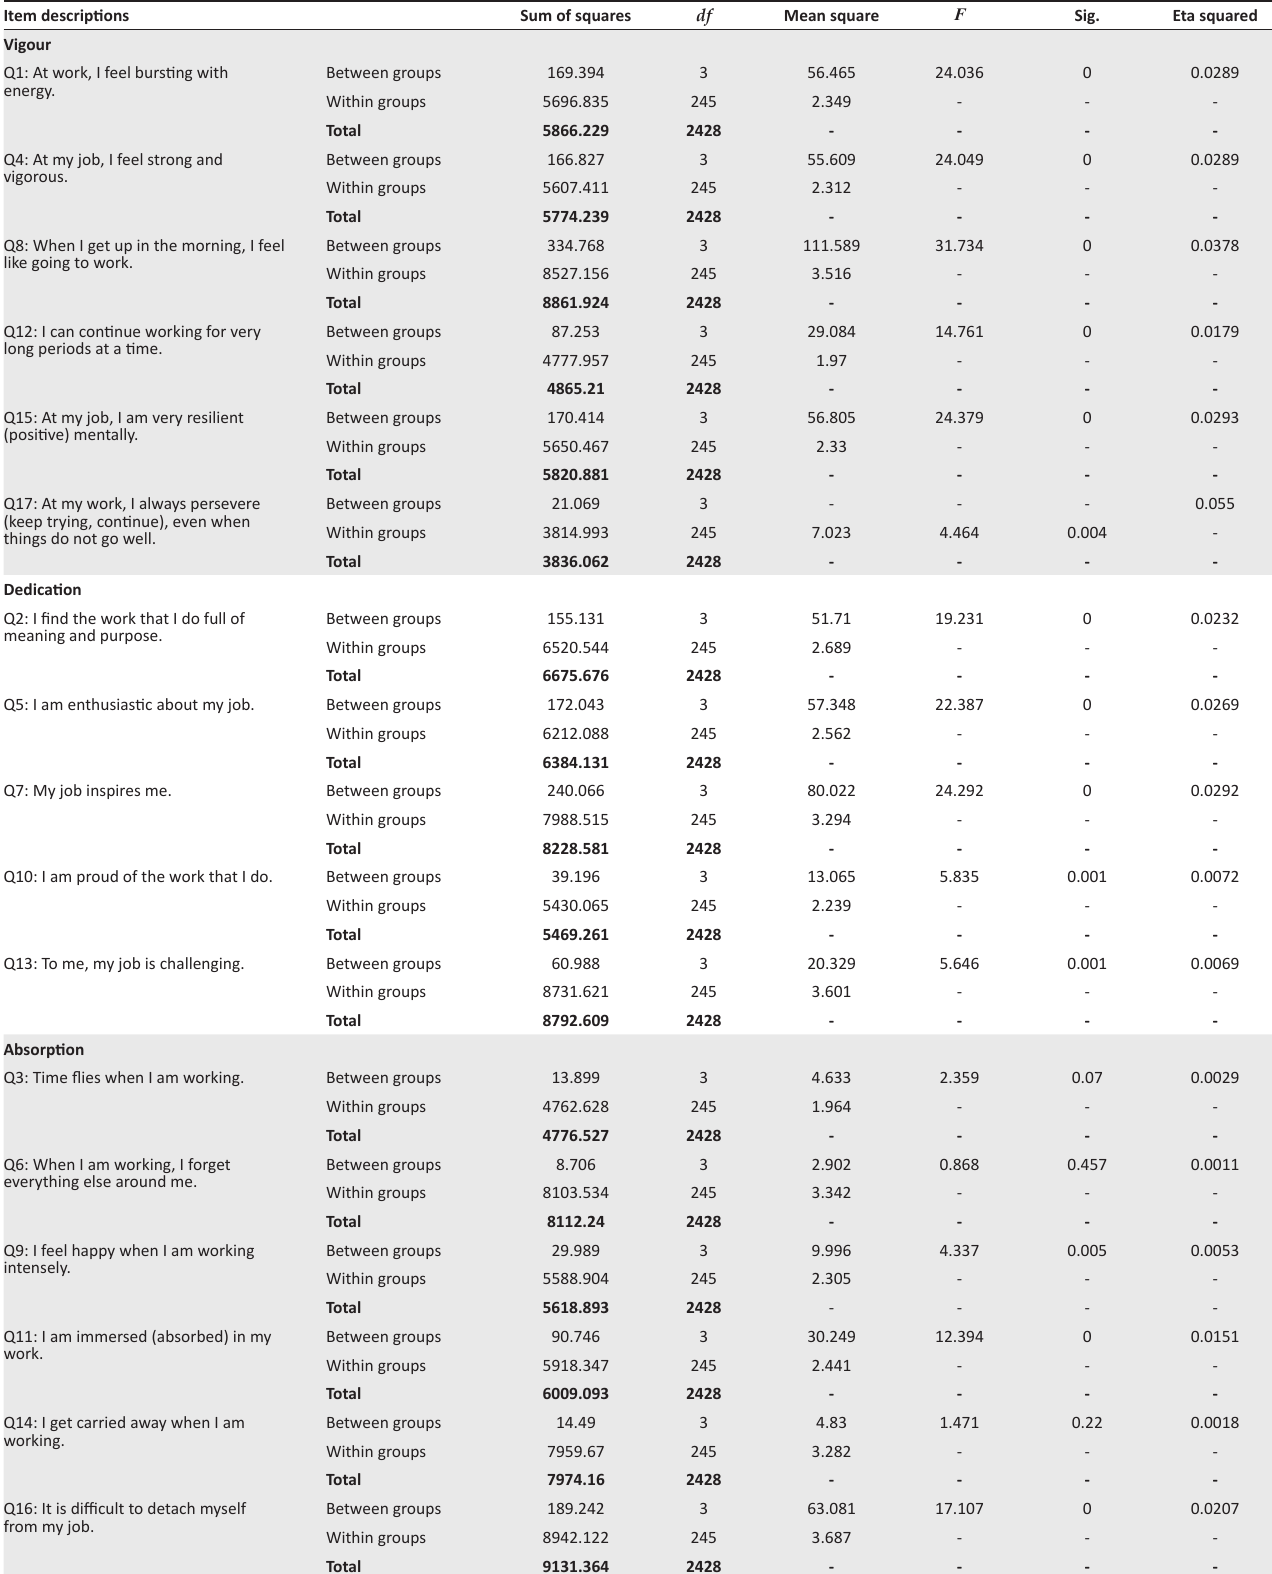
TABLE 5: Summary of ANOVAs between cultural groups per